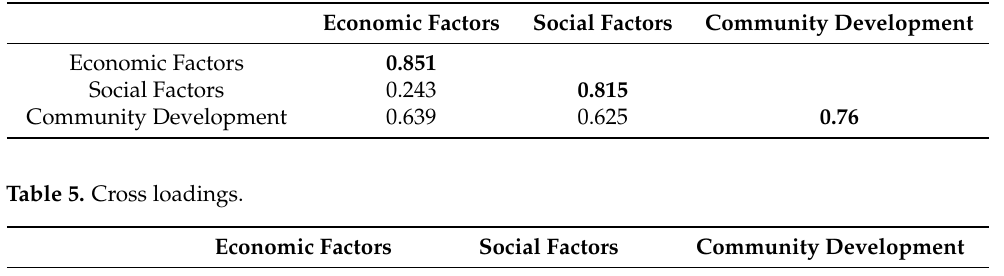
Table 4. Fornell–Larcker criterion test.